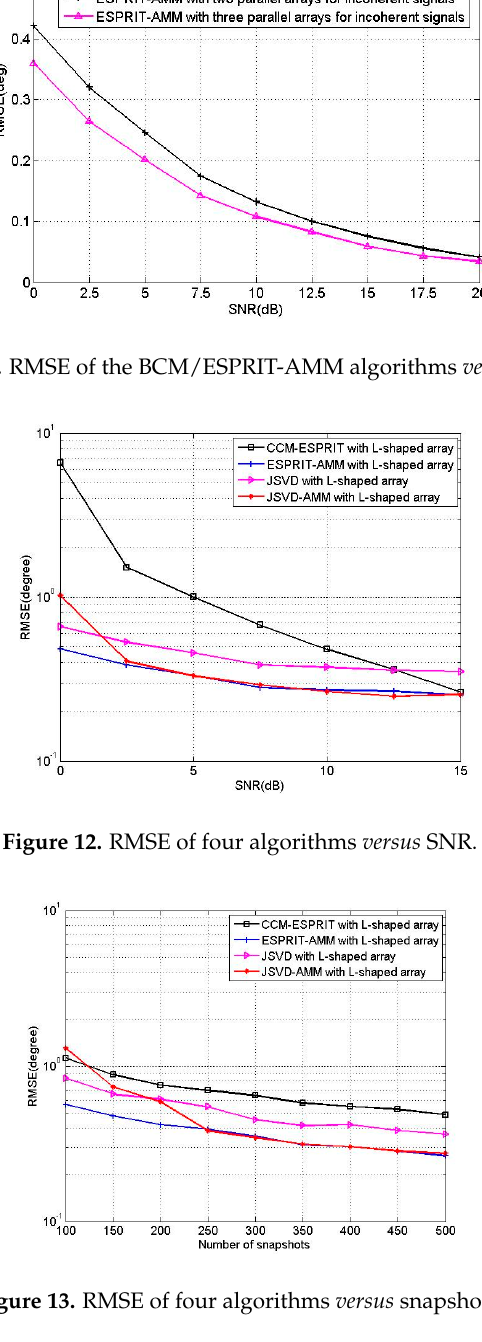
Figure 11. RMSE of the BCM/ESPRIT-AMM algorithms versus SNR.